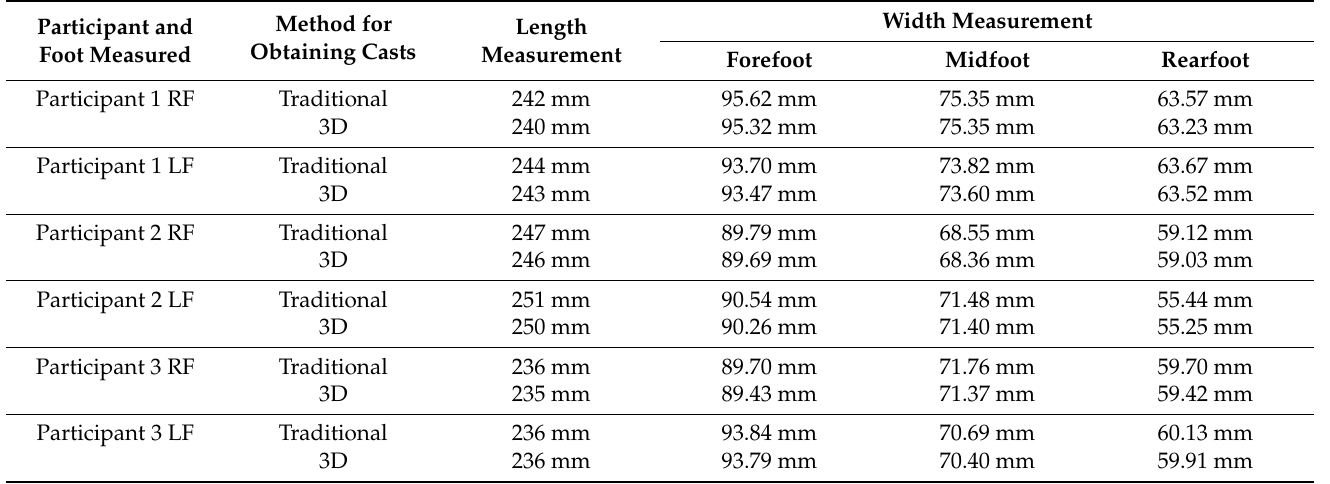
Table 1. The detail of dimension measurements of the cast obtained through traditional and digital fabrication